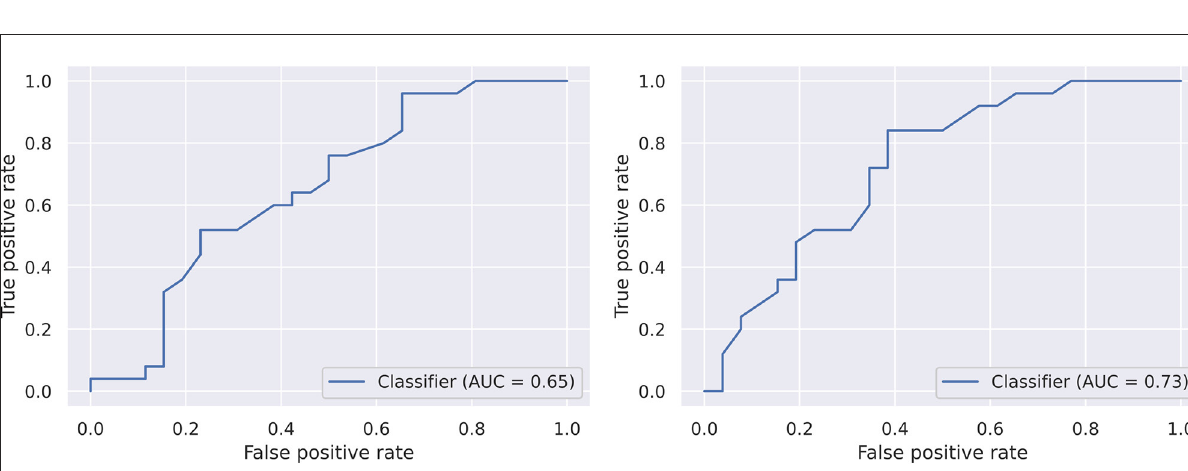
There were significant effects of task ( F 2,9706 < 0.0001) and group-by-task interaction ( F 2,9706 <